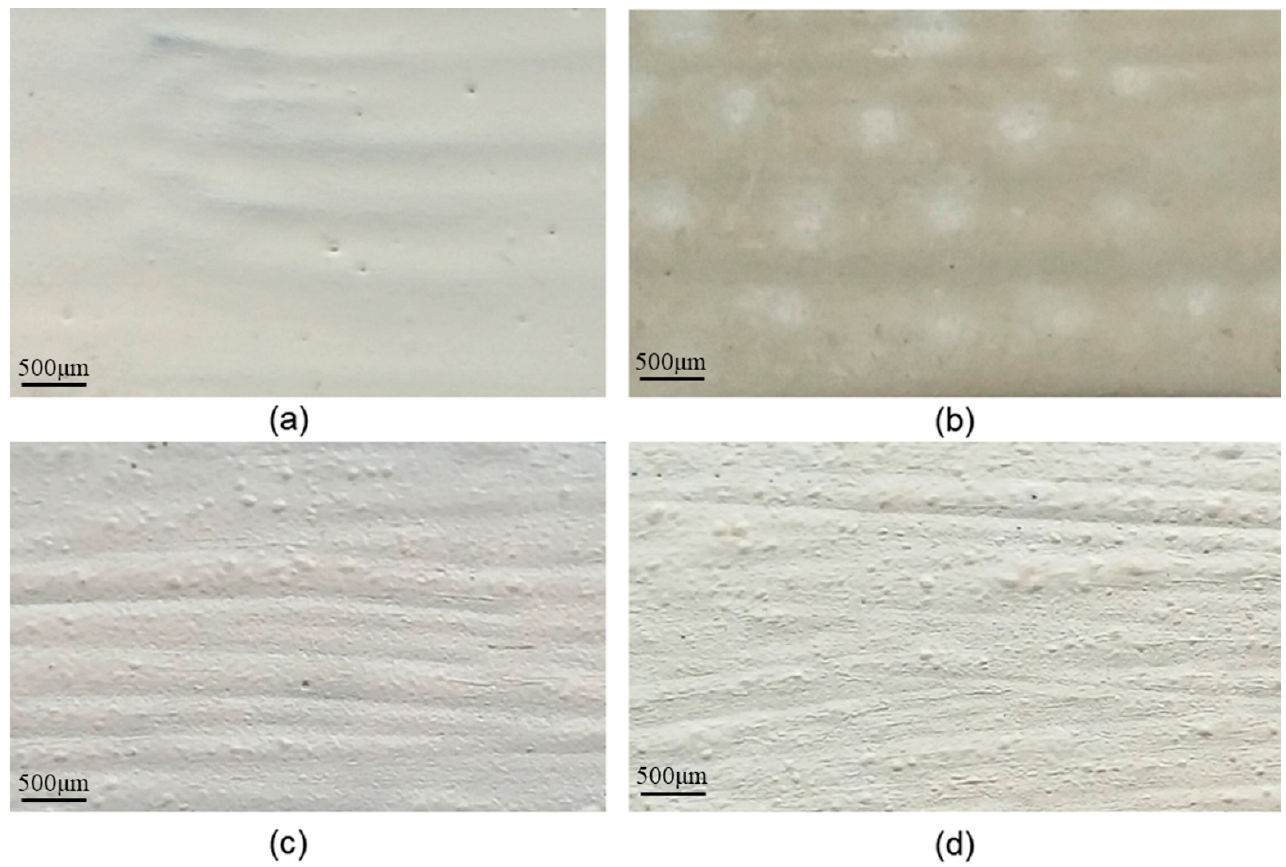
Figure 1. The appearance of samples surfaces: ( a ) electrode N–white grey, glossy appearance; ( b ) electrode G (aged 72 h)-yellowish-white, with degraded areas (matte), ( c ) N3 (non-aged)-dark white, semi-glossy appearance, and ( d ) G3 (aged of 72 h)-grey, matte appearance.